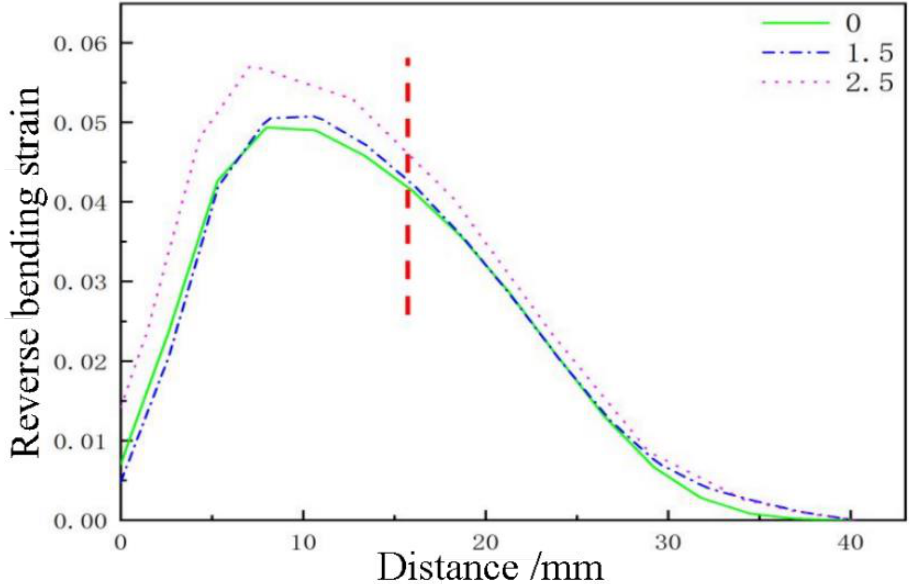
Figure 22. Reverse strain curves at different drawbead heights.